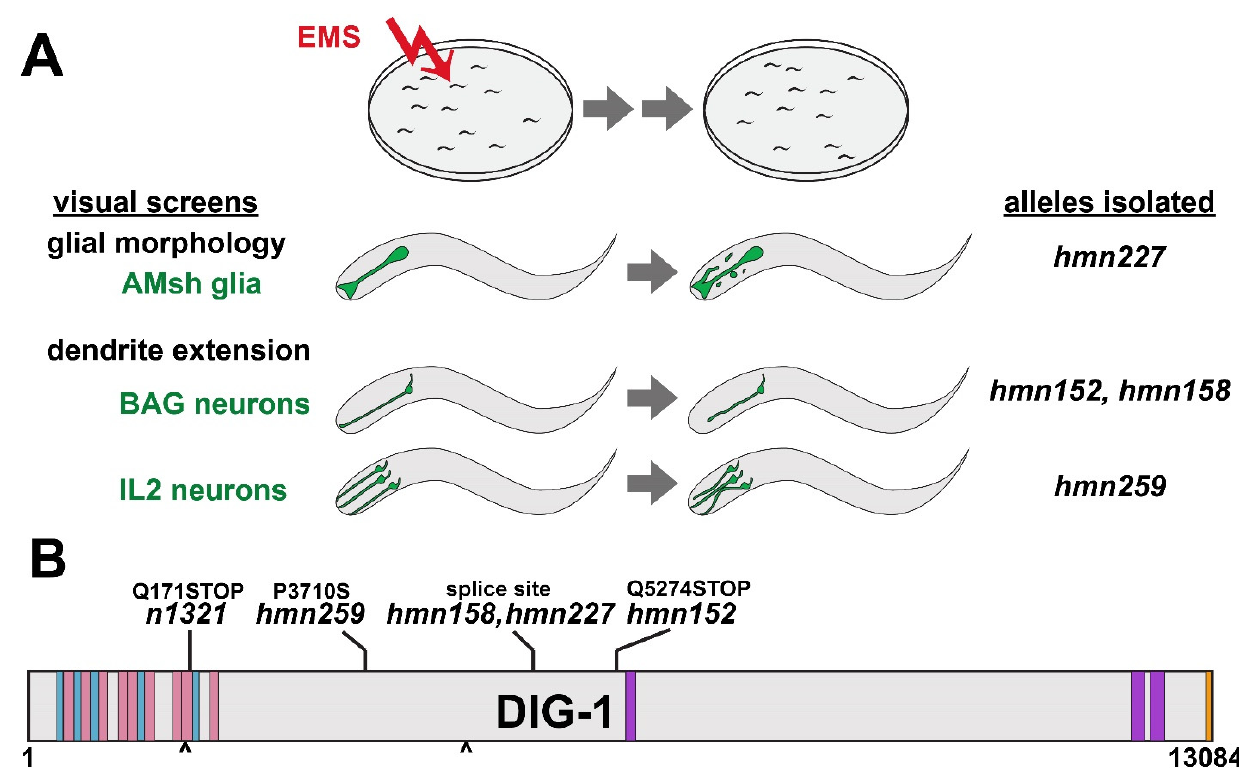
Figure 1. Overview of genetic screens and dig-1 alleles. ( A ) Schematic of screening strategy, phenotypes, and resulting alleles isolated. Animals bearing markers for the amphid sheath (AMsh) glia, BAG neurons, or IL2 neurons were mutagenized with ethyl methanesulfonate (EMS), grown for two generations, and screened for morphology defects, yielding four alleles of dig-1 . ( B ) Schematic of DIG-1 protein depicting the nature of each newly isolated allele as well as the reference allele n1321 used throughout this study. Blue, Ig domains; pink, FN domains; purple, VWA domains; orange, EGF domain; carets, RGD motifs.